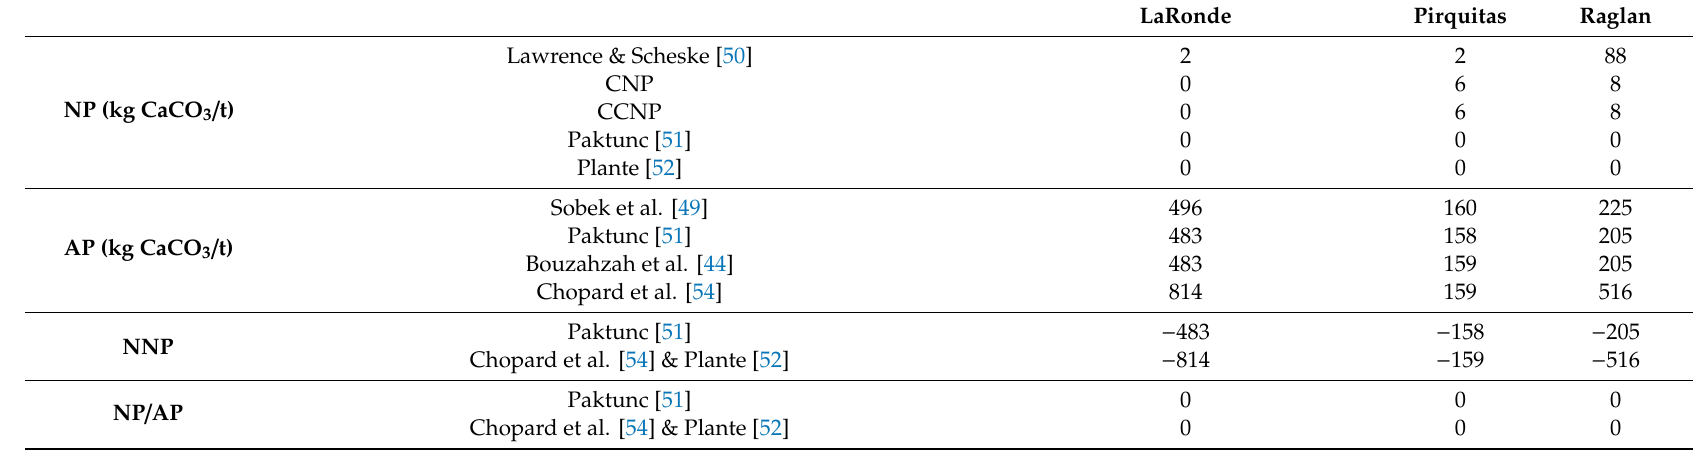
Table A5. Di ff erent estimations of the acid-generation potential (AP) and the neutralization potential (NP) according to di ff erent mineralogical methods; and neutralization net potential (NNP) and NP / AP